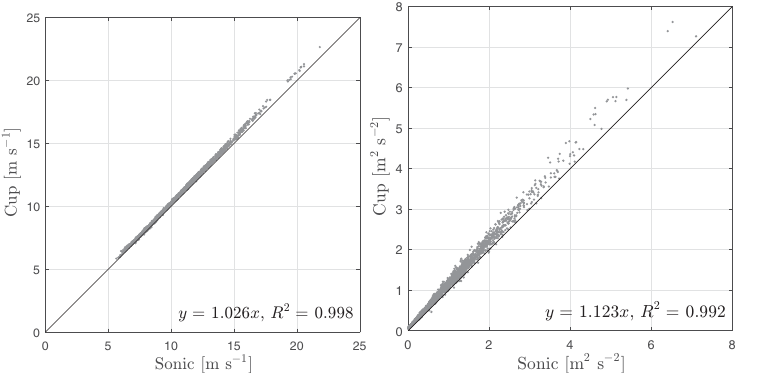
Figure 8. Comparison of sonic and 80m cup anemometer statistics: mean wind speed (left frame) and horizontal-wind variance (right frame). Each 10-min sample is shown in grey markers, a 1:1 line is shown for guidance in black, and the results of a linear regression through the origin and R 2 are given. αε 2 / 3 =0 . 14 m 4 / 3 s − 2 , and L =35 . 38 m) are similar to those observed at a site with similar surface and turbulence char- acteristics (Peña et al., 2010), but it should be noticed that these are the average of spectra for a number of atmospheric and turbulence conditions and that the Mann-model fitting procedure is normally performed over specific wind-speed, turbulence, oratmospheric-stabilityranges. Duetotheuncertaintyonthesonic-derivedstatistics,wewillusethecup-anemometervarianceasaproxyfor σ 2 u .However, 5 we will use the sonic-based Mann parameters for comparison with the lidar-based Mann parameters (and for estimations of σ 2 v,w and u (cid:2) w (cid:2) )becauseitistheonlyreferencewehaveforthree-dimensionalturbulencemeasurements.